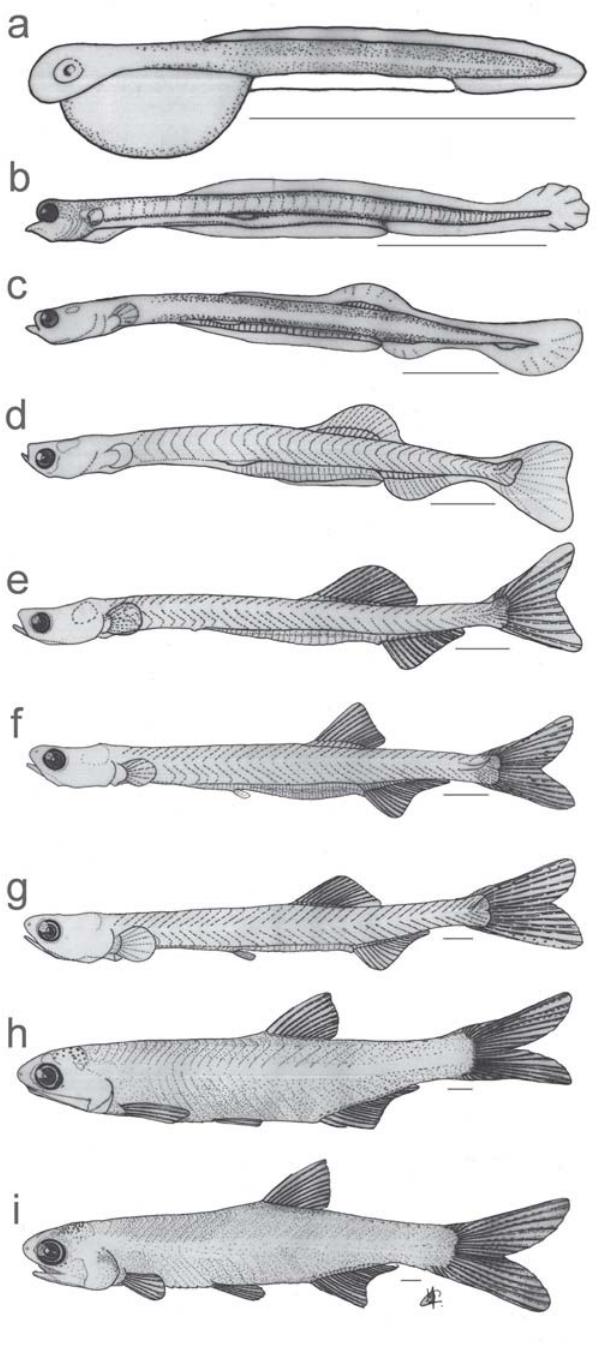
Fig. 1. Larva and juvenile Anchoviella vaillanti : 1.7 mm yolk-sac larva ( a ), 3.2 mm ( b ) and 5.5 mm ( c ) preflexion larvae, 7.6 mm ( d ) and 10.7 mm ( e ) flexion larvae, 13.8 mm ( f ) and 16.0 mm ( g ) postflexion larvae, and 25.5 mm ( h ) and 30.0 mm ( i ) early juveniles. Scale bar = 1